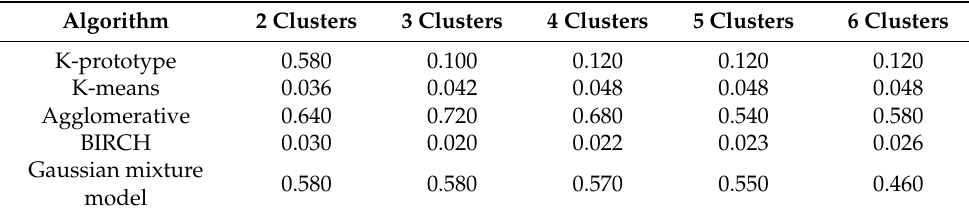
Table 1. Number of clusters vs. silhouette score for the algorithms used in the study.